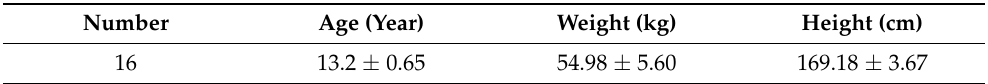
Table 1. The basic information of the